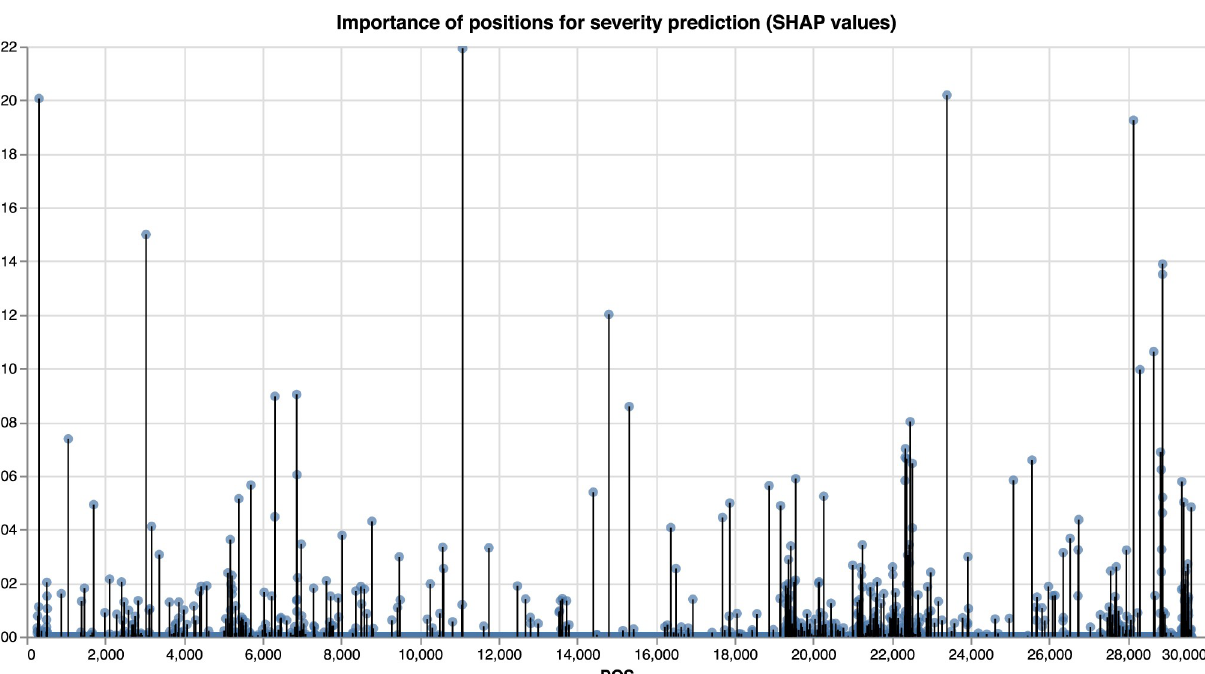
PLOS Computational Biology | https://doi.org/10.1371/journal.pcbi.1009183 July 14,